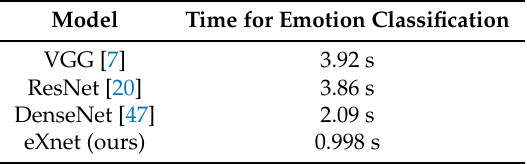
Table 7. Time comparison of proposed model with benchmark networks on Raspberry Pi